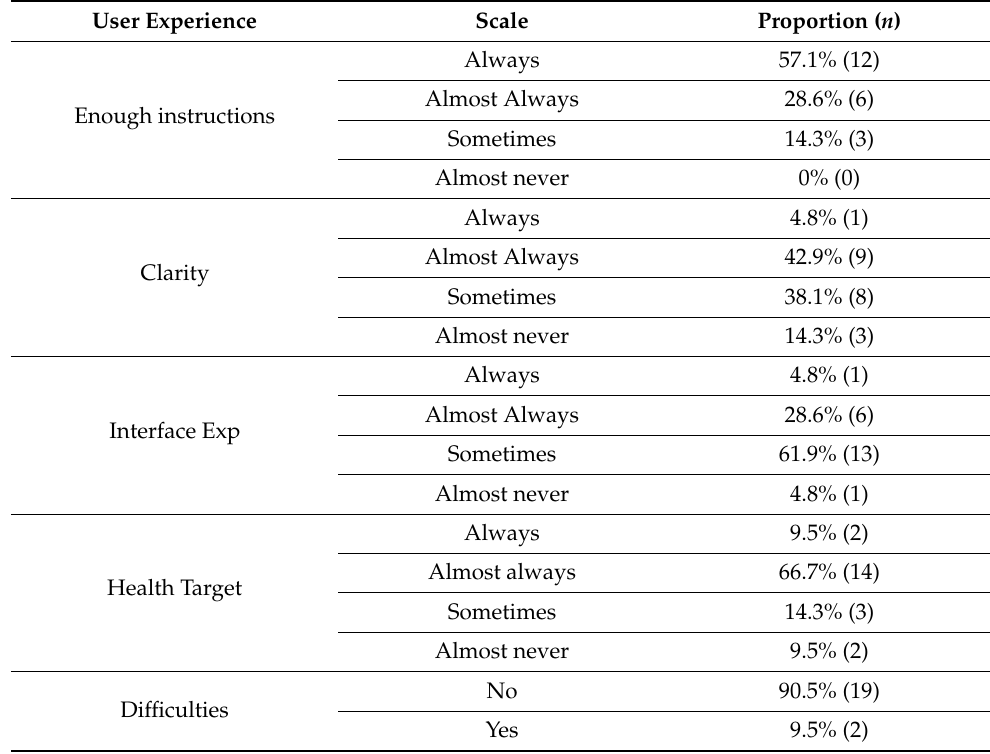
Table 5. Outcomes of user experience in proportions according to the Likert